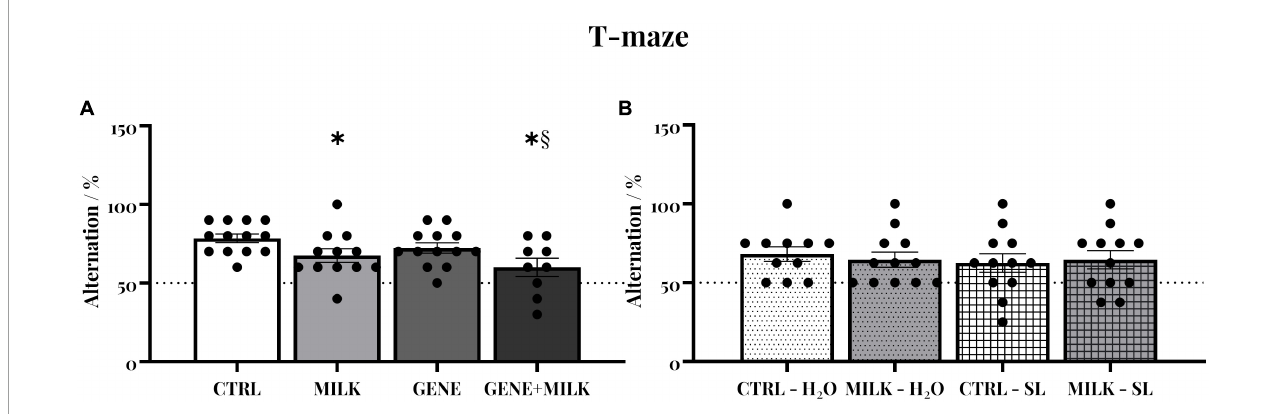
FIGURE2 Spontaneous alternation: Percentage of alternations between the two arms of the T-maze in experiment 1 (A) and experiment 2 (B) . The dashed lines represent the chance level. ∗ p < 0.05 in post-hoc tests compared to CTRL group, § p < 0.05 in post-hoc tests compared to GENE group.